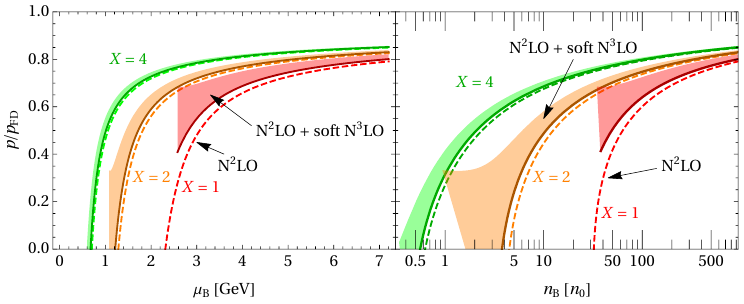
Figure 3. A comparison between the state-of-the-art pressure of cold QM at partial N3LO, including the interactions between soft screened modes, and the corresponding N2LO pressure given as functions of the baryon chemical potential µ B (left) and baryon number density n B (right). Both pressures are shown normalized by the free Fermi–Dirac pressure p FD . The three colors correspond to the renormalization- scale variation in the hard sector, and the solid lines in the N3LO result correspond to fixing the factor- ization scale ⇤ h to the PMS value. The filled bands in the N3LO result correspond to varying ⇤ h by a factor of two in both directions about the PMS